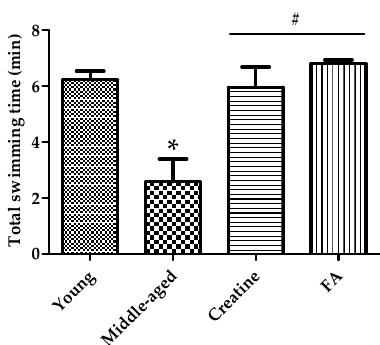
Figure 2. Effect of FA on swimming capability of mice. Data are expressed as the mean ± SD ( n = 5 mice per group), and p -values < 0.05 (*) as compared with the young control or p -values < 0.05 (#) as compared with the middle-aged control mice.